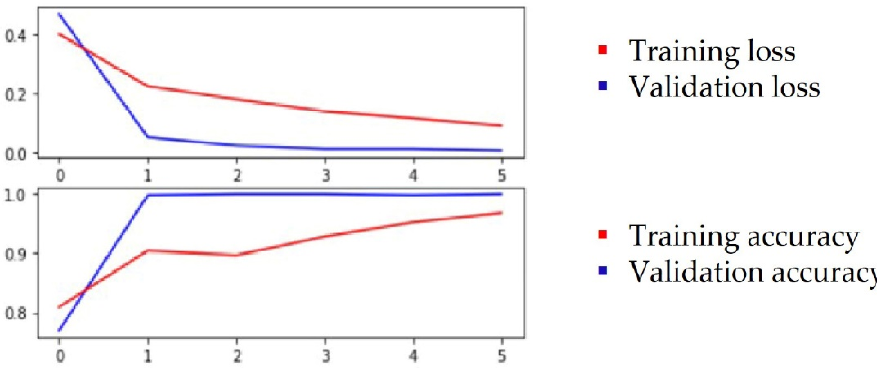
Figure 4. Plot of the training and validation loss and accuracy for ResNet152.